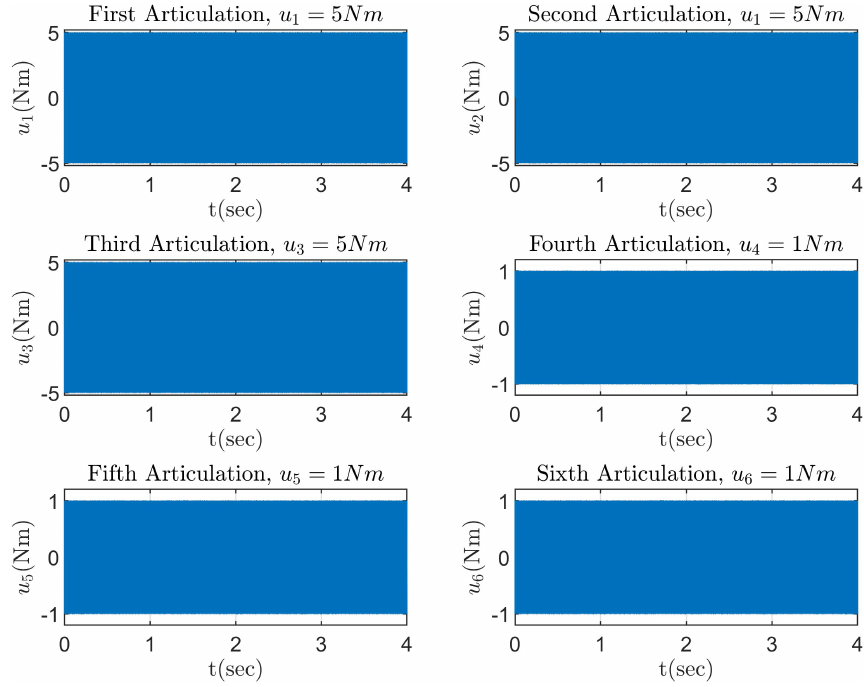
Figure 13. Input signal